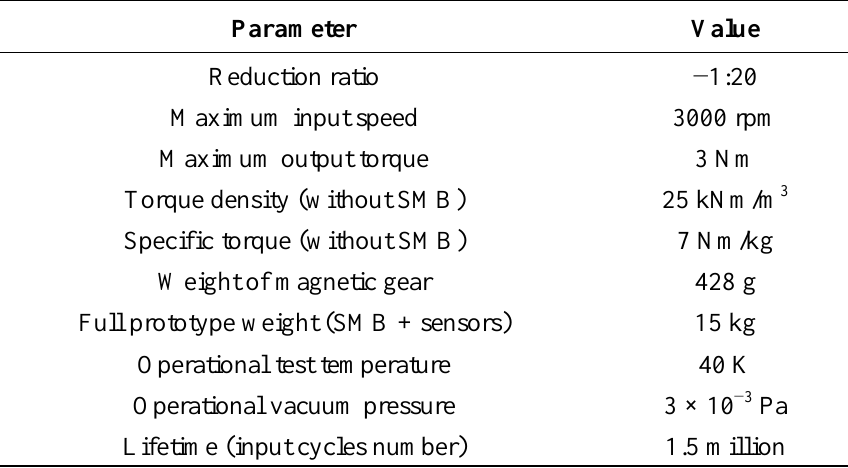
Table 1. Performance test results of the MAGDRIVE